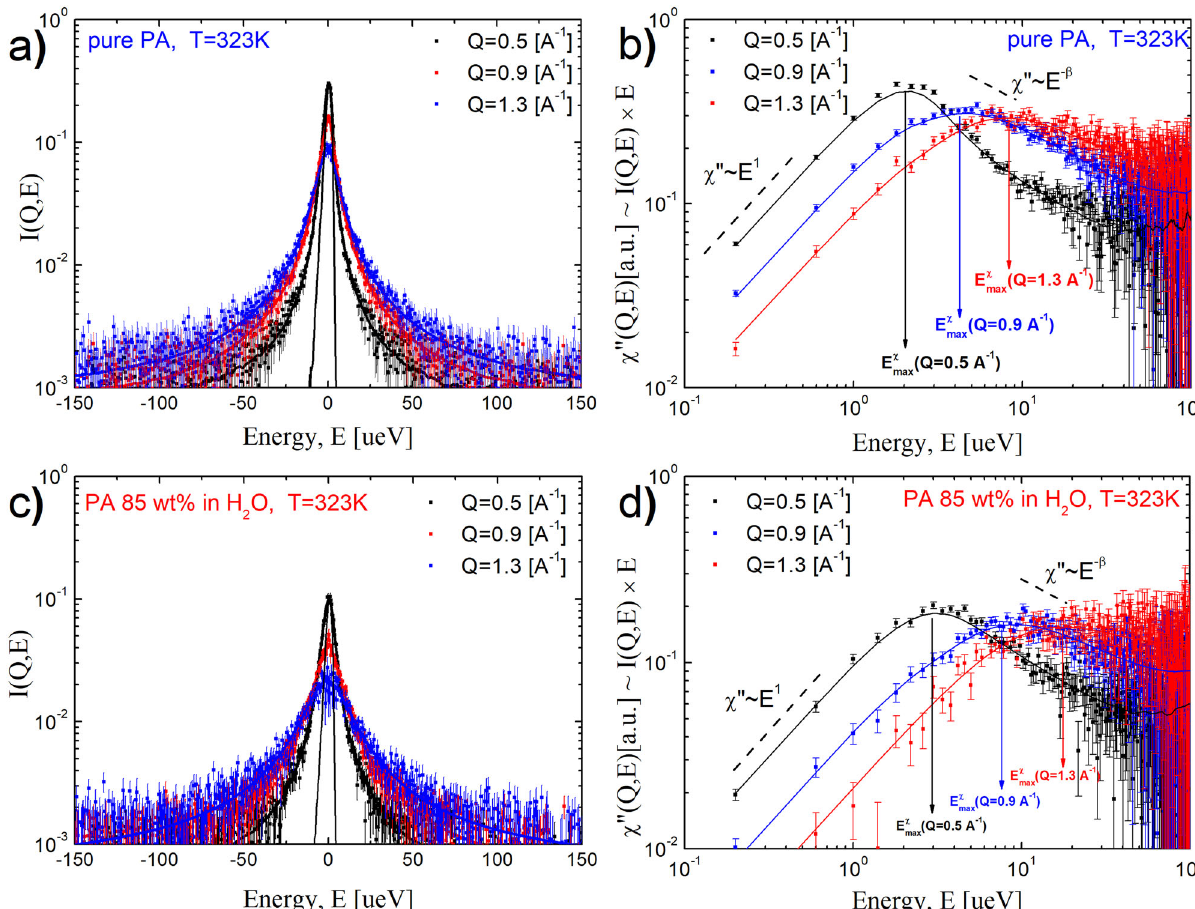
Fig. 5 QENS spectra in intensity and susceptibility format. Intensity and corresponding susceptibility presentation of the QENS data, respectively, for pure PA a , b PA 85 c , d . Lines present fi t to the Cole-Davidson function. For a complete description of the fi tting procedure see the SI. The arrows in b , d show ð Q Þ . This value in the case of the Cole-Davidson the energies corresponding to the maximum of the relaxation peak in the susceptibility spectra, E χ max function is close to HWHM, but takes into account the distribution of the relaxation processes. In plots a and c the resolution functions (measured at 20 K) are shown to demonstrate the broadening of the scattering peak. Error bars are standard